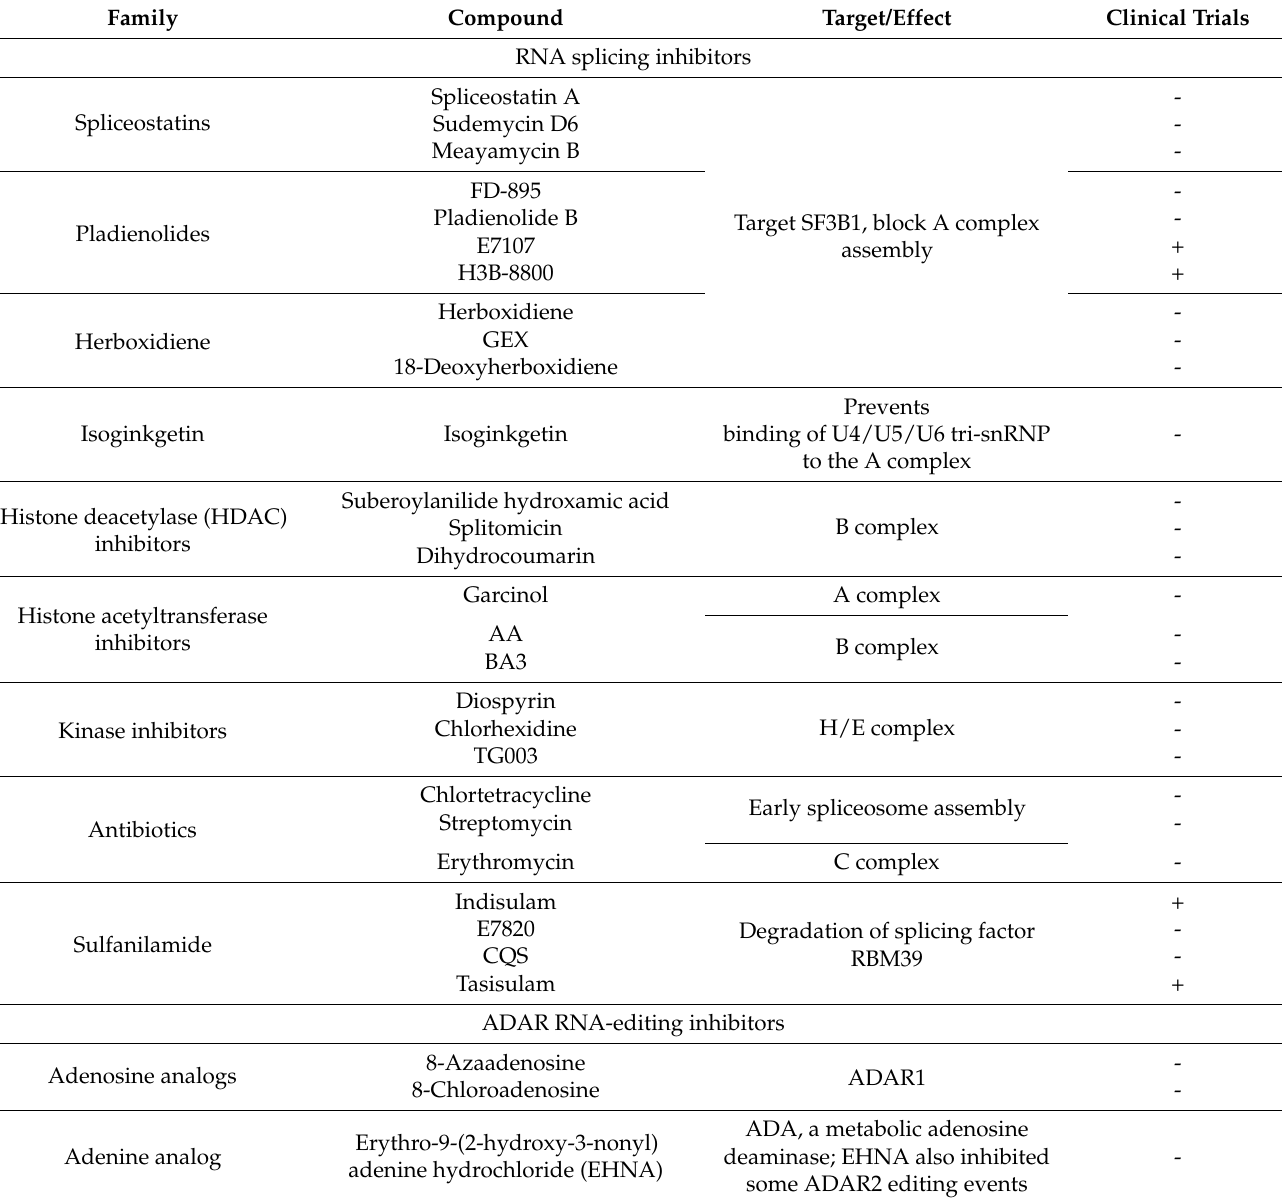
Table 1. Small-molecule splicing and ADAR editing